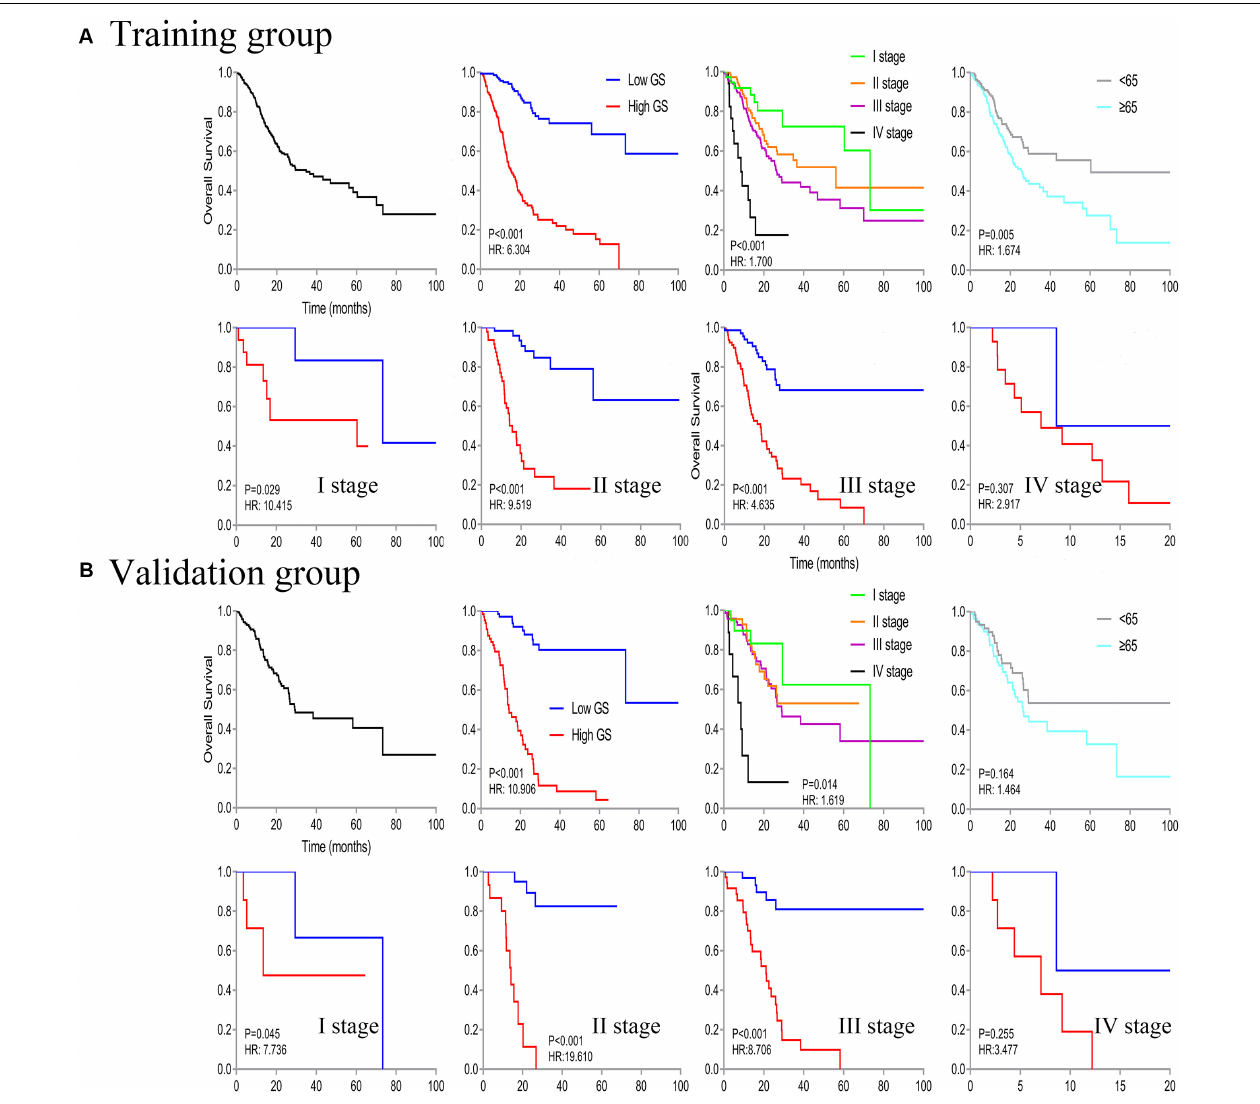
FIGURE 3 | Kaplan–Meier curve of overall survival in all patients, then stratified by genomics score (GS), pathological stage, and age. Survival analysis in the low- and high-GS groups was further divided based on stages (stages I–IV).